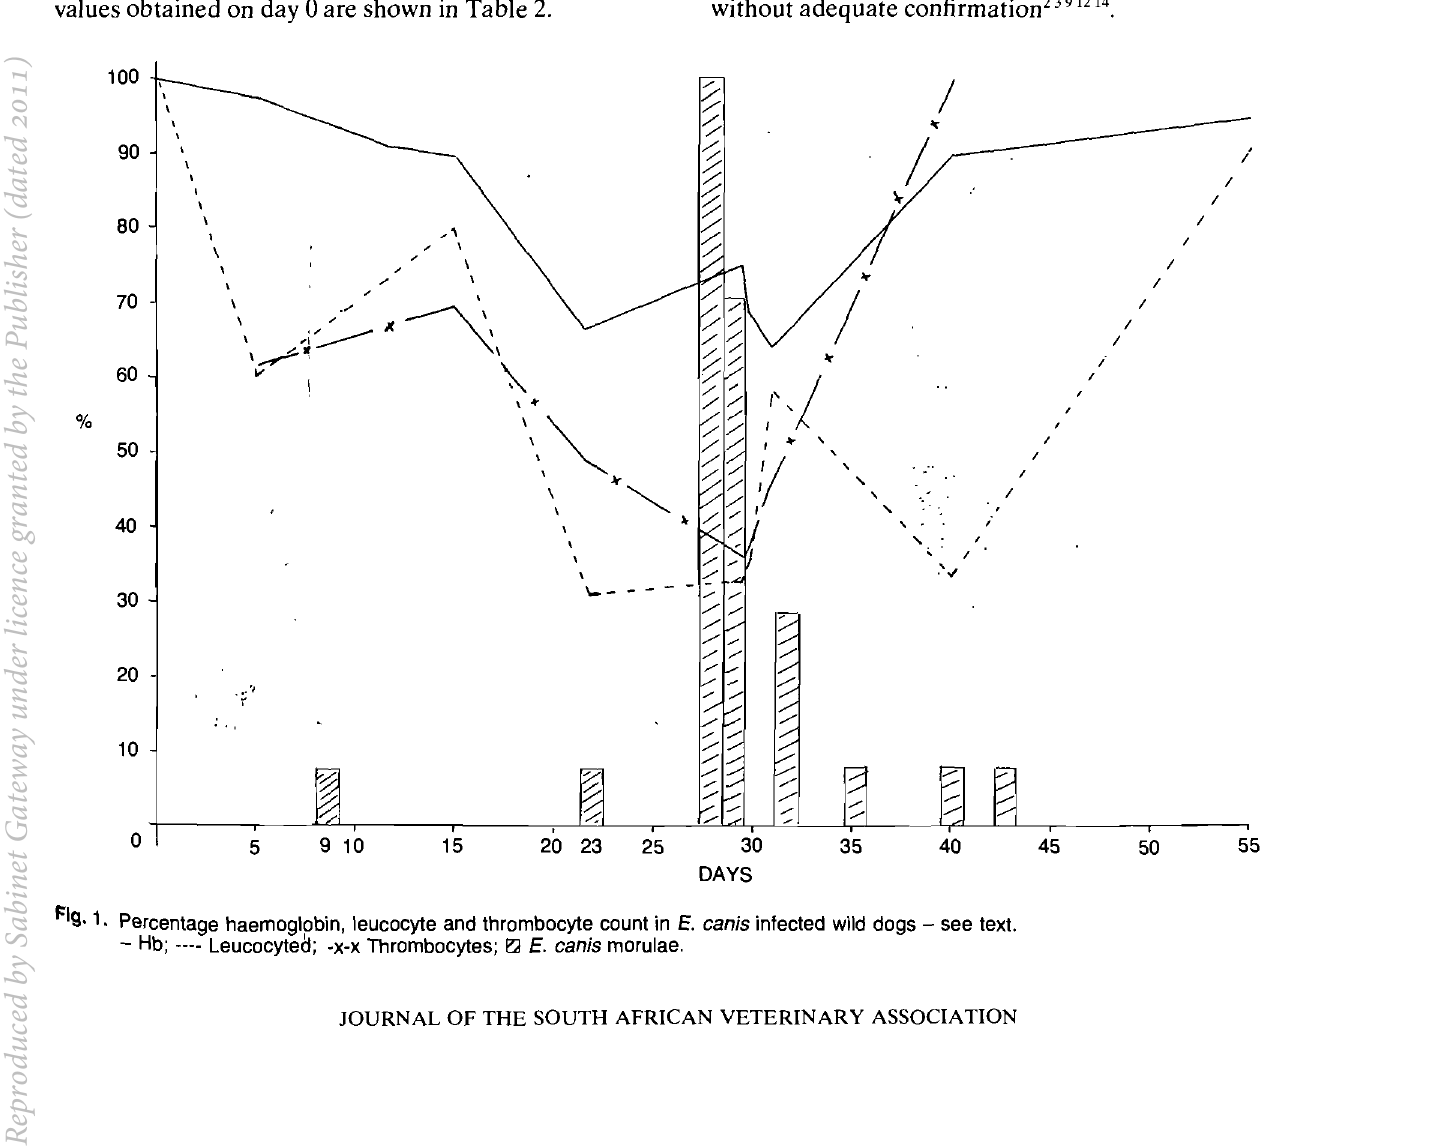
Fig. 1. Percentage haemoglobin, leucocyte and thrombocyte count in E. canis infected wild dogs - see text. - Hb; ---- Leucocyted; -x-x Thrombocytes; f72 E. canis morulae.